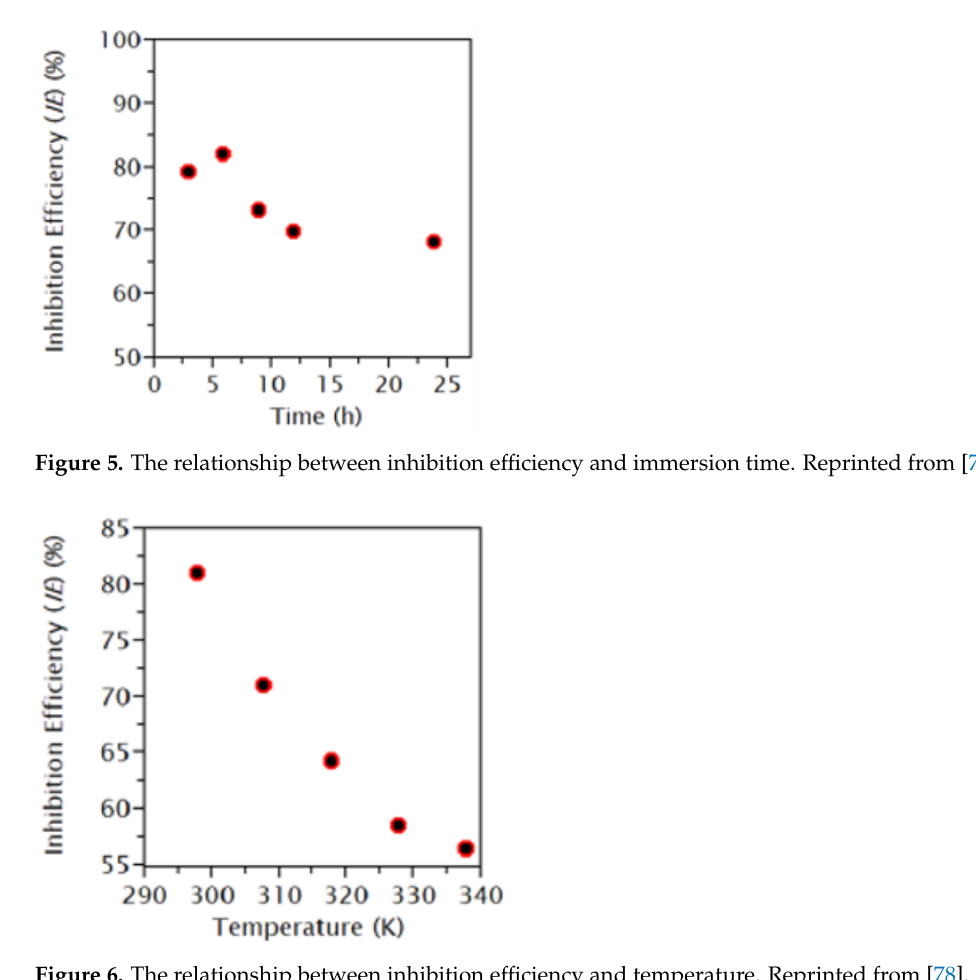
Figure 6. The relationship between inhibition efficiency and temperature. Reprinted from [78].